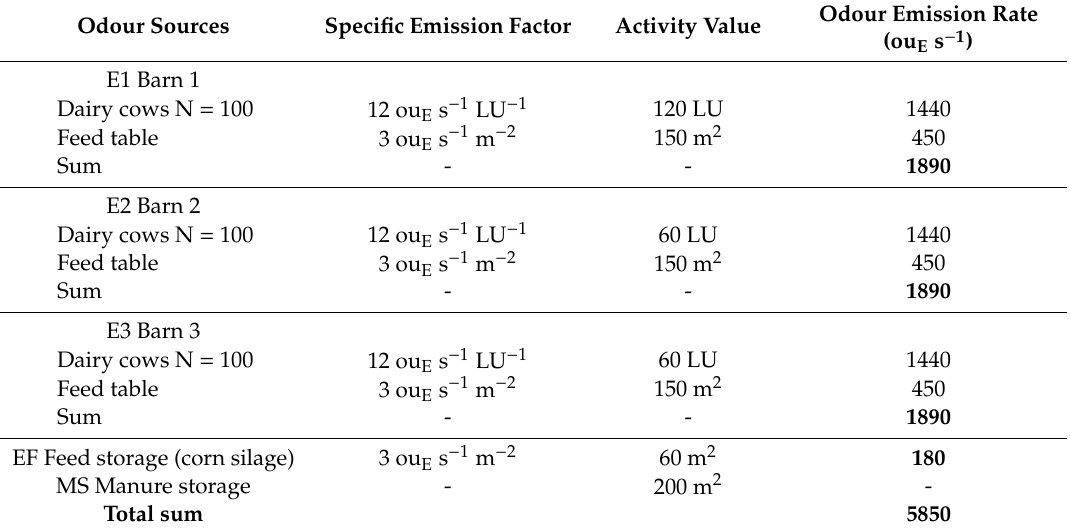
Table 1. Odour emission rates for the odour sources identified in the dairy farm. The emission factors are based on the VDI 3894 Part 2